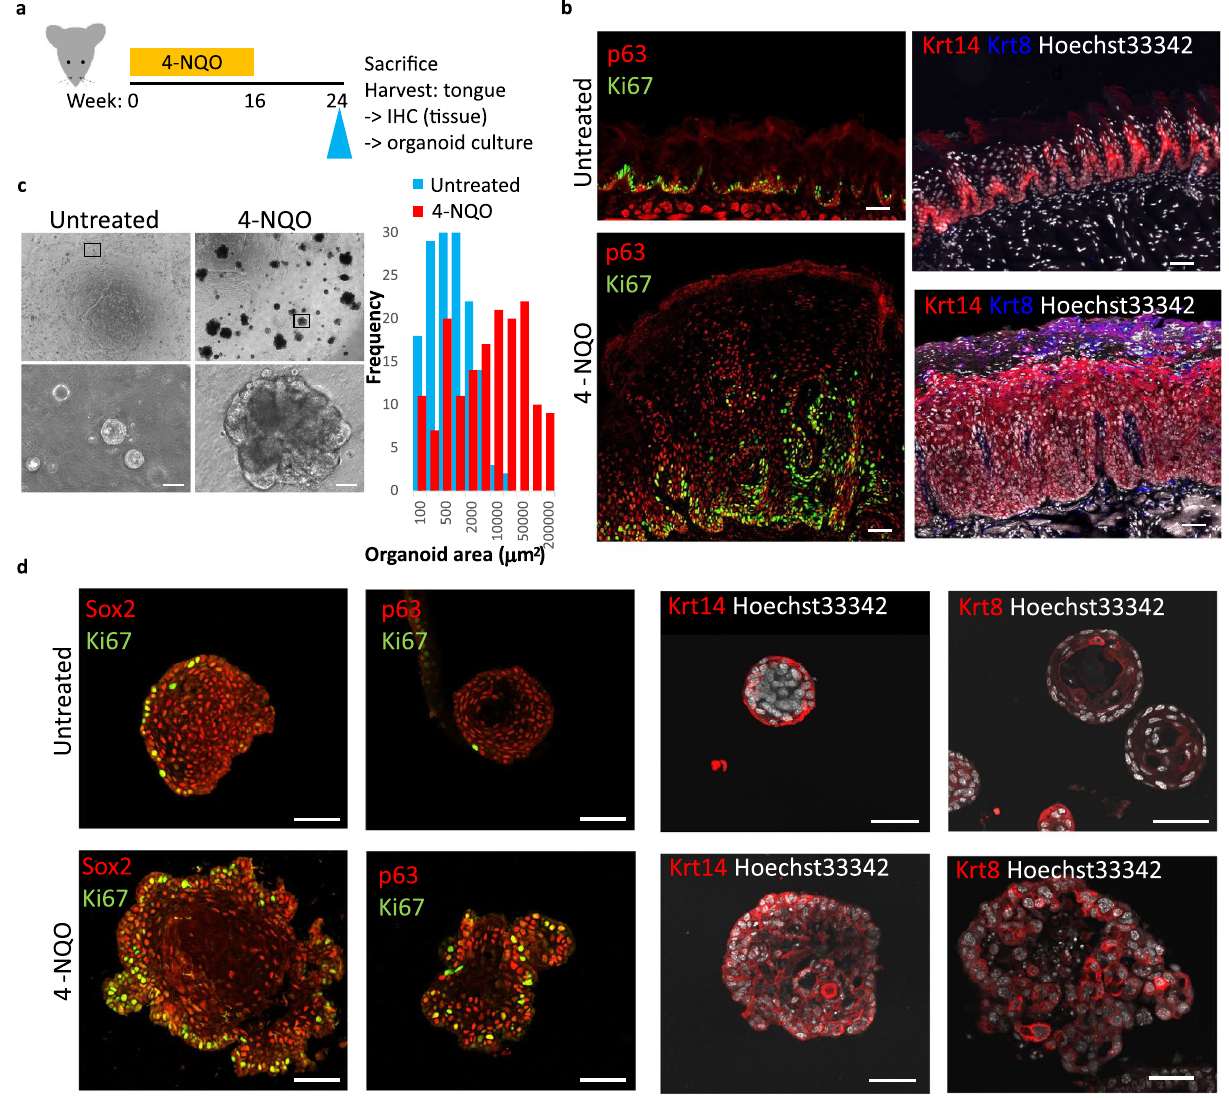
Figure 1. Induction of tongue cancer and histological analysis of non-malignant and malignant lingual epithelial tissues and organoids. ( a ) Scheme for 4-nitroquinoline-1-oxide (4-NQO) treatment of mice and tongue harvesting. ( b ) Immunostaining of lingual epithelial tissue of untreated (upper panels) and 4-NQO- treated (lower panel) mice with the indicated primary antibodies. ( c ) Isolated lingual epithelial organoids from untreated (left) and 4-NQO-treated (right) mice at day 12 after single-cell seeding in Matrigel. The lower panel shows the magnified images of the upper panel. The graph shows the frequency of organoids of different sizes from untreated and 4-NQO-treated mice. ( d ) Immunostaining of lingual epithelial organoids from untreated (upper panel) and 4-NQO-treated (lower panel) mice with the indicated primary antibodies. Scale bars = 50 cells were observed in most cancer clusters but were few in the stem-like cell cluster. In the control, on the other hand, Krt8 was mostly expressed in the stem-like cell cluster. Trajectory analysis. To investigate changes in gene expression during the differentiation of stem/progeni- tor cells in the control and cancer organoids, trajectory analysis of the Seurat objects was performed using the Monocle3 package (Fig. 3a). The clusters with the highest StemID values were denoted the root nodes and the pseudotime and trajectory paths were estimated (Fig. 3b). Selected markers for stem, proliferative, and dif- ferentiated cells were plotted in pseudotime for the control and cancer datasets (left and right, respectively, in Fig. 3c). In both control and cancer organoids, the expression of Hopx and the suprabasal keratinocyte markers Krt13, Krt4, and Krt6a increased with pseudotime while Lgr6-expressing cells were enriched in undifferentiated cells. The expression of Krt8 increased with pseudotime in the cancer organoids but was high in both stem-like and differentiated cells in the control organoids. Furthermore, the expression of Trp63 decreased gradually over pseudotime in cancer organoids but peaked in the middle of the trajectory in control organoids. The expression